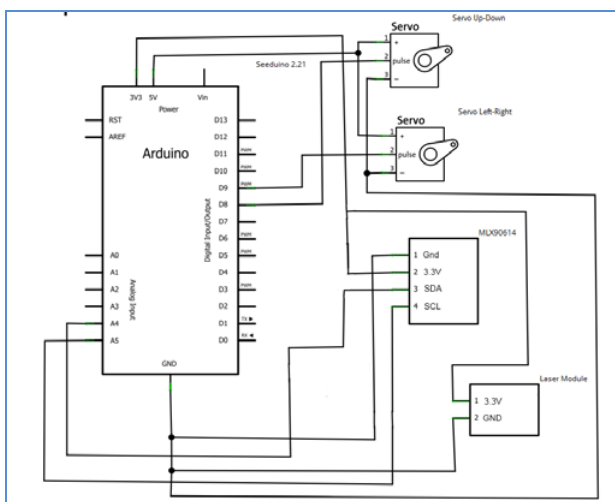
Figure 6. Wire diagram of the camera